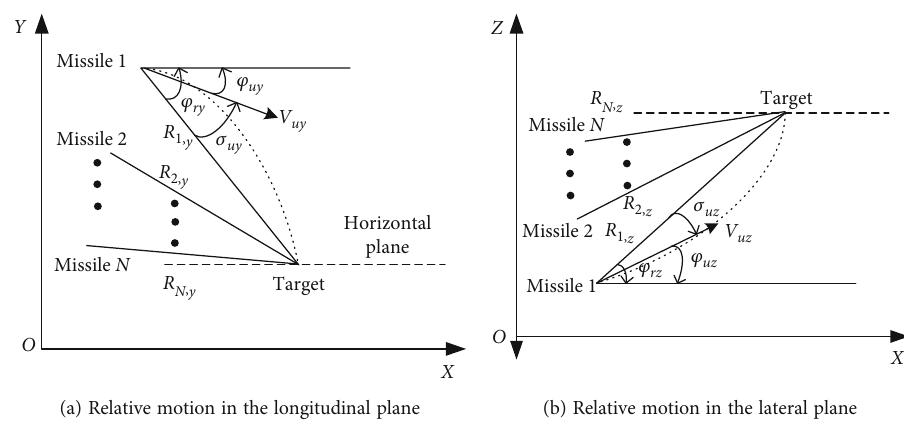
Figure 1: Relative motion relationship between N missiles and one